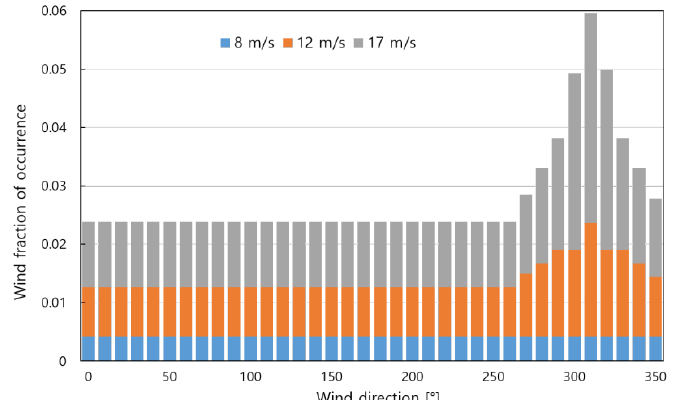
Figure 4. Wind fraction of the probability of occurrence by direction for case study (c).